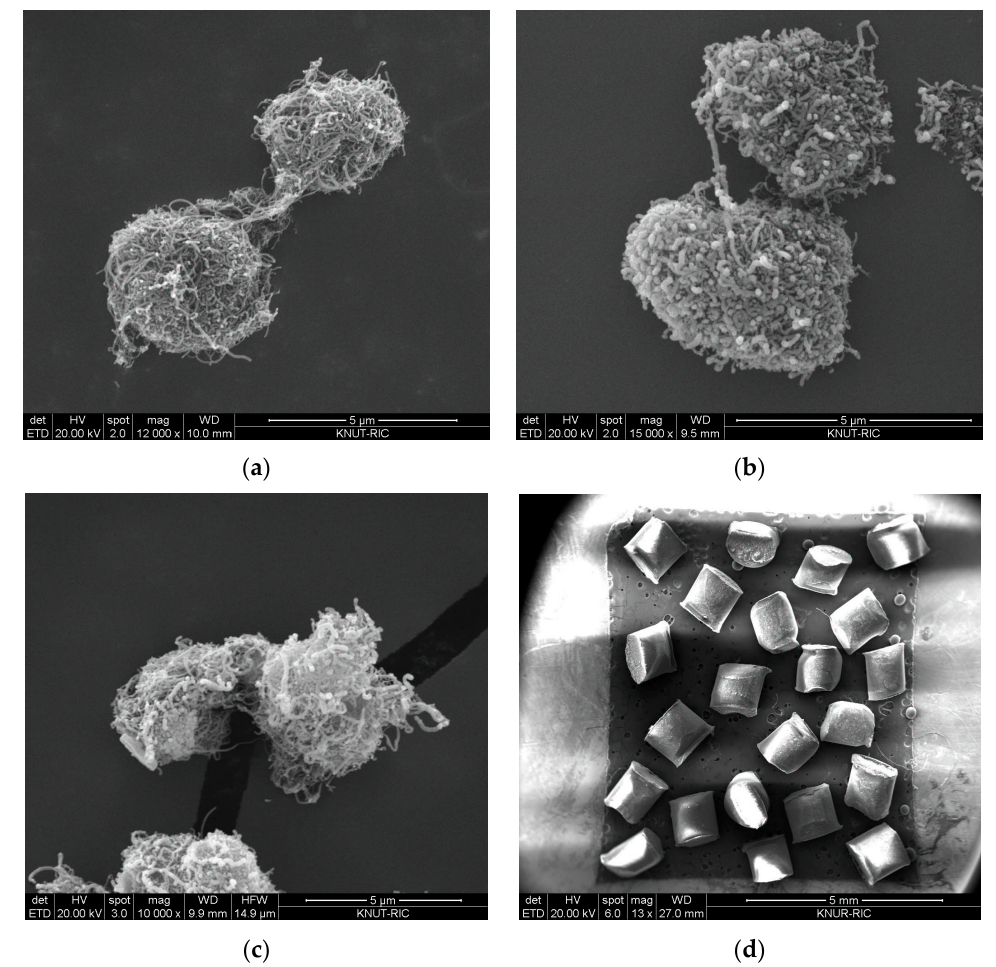
Figure 1. SEM images of particles used in experiments: ( a ) VACNT; ( b ) ENCNT-I; ( c ) ENCNT-II; ( d ) PC (scale bar length: carbon nanotubes (CNTs) = 5 µ m; PC = 5